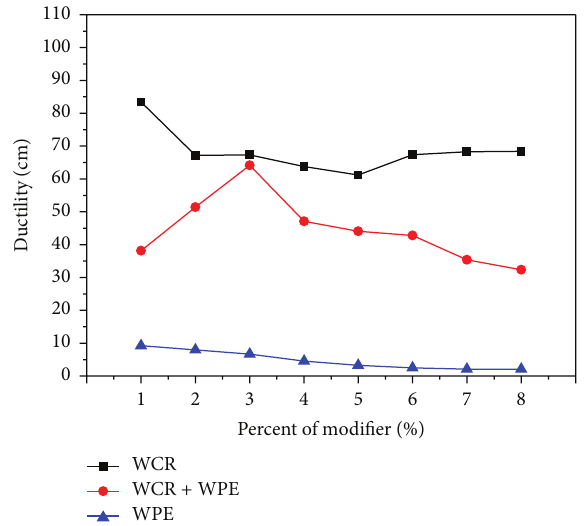
Figure 2: The ductility of modified asphalt at 5 ∘ C.